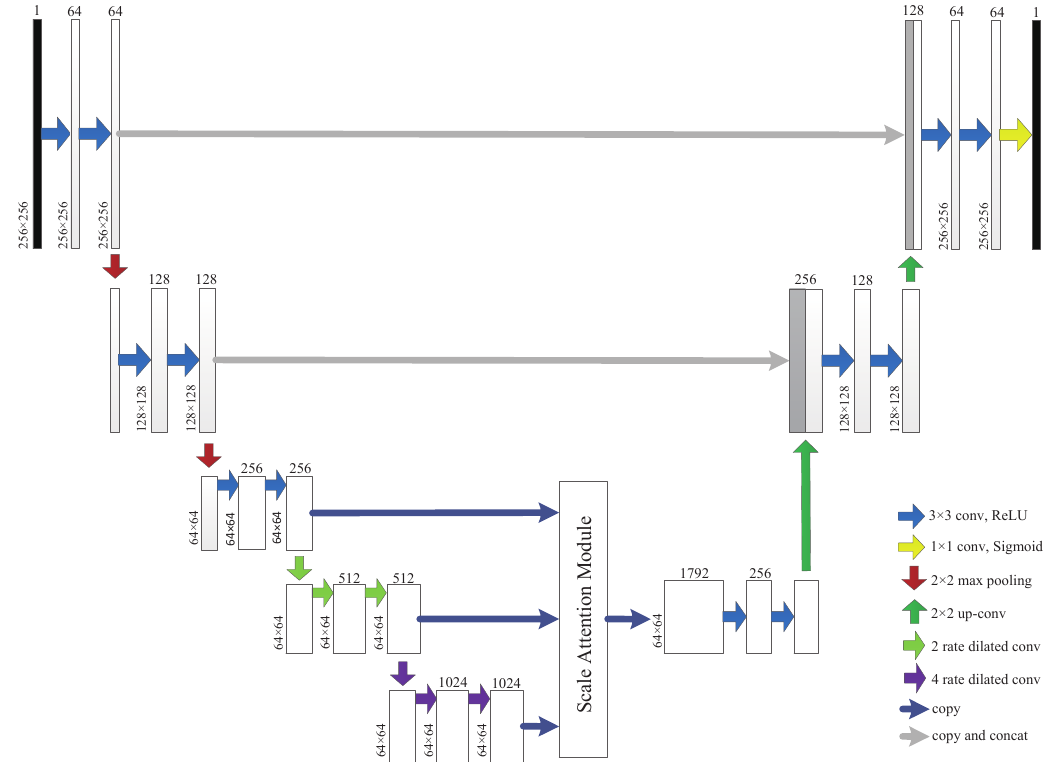
Figure 2. Complete architecture of the Scale Attention Pyramid U-Net with dilated convolution at different